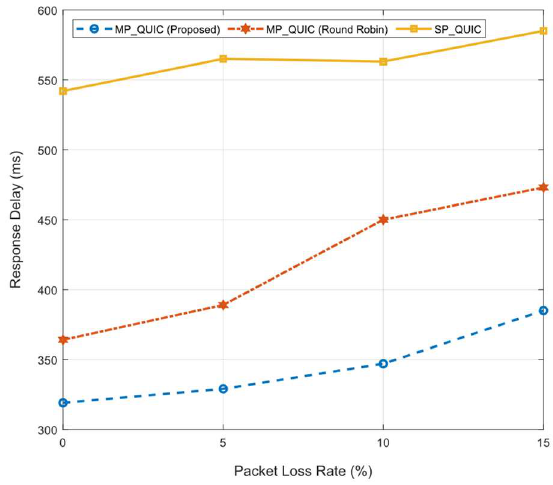
Figure 3. Comparison of response delays for different link delays.